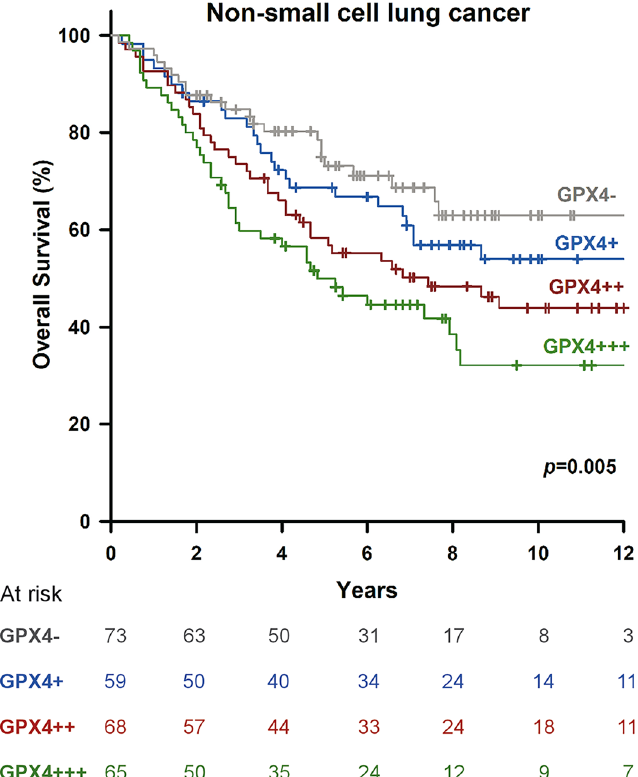
Figure 2. Different levels of glutathione peroxidase 4 expression, stratified by immunohistochemical stain, were significantly associated with 5-year overall survival ( p =